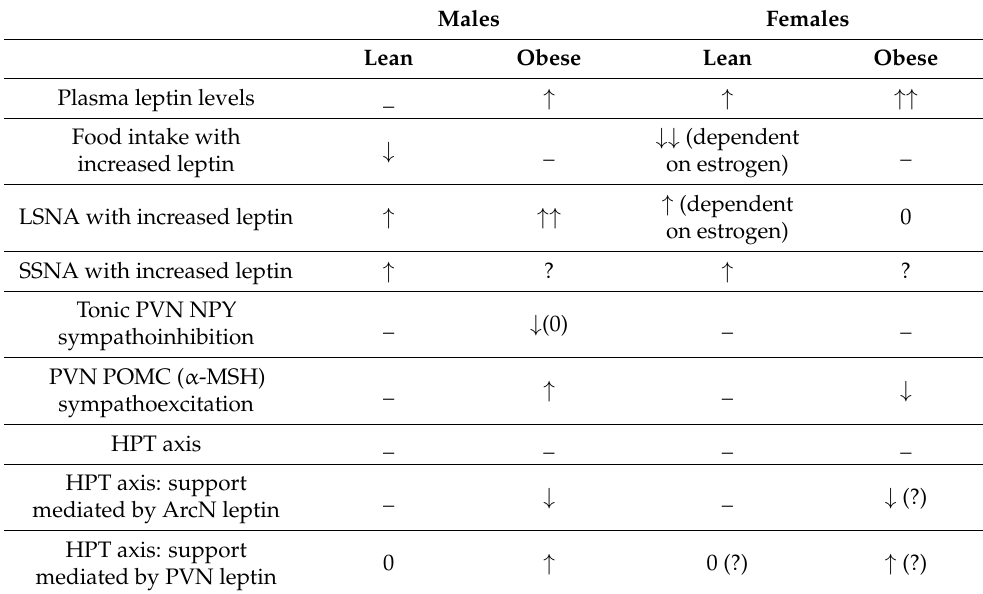
Table 2. While the increased leptin levels that occur with obesity fail to suppress food intake in both sexes, its actions to increase SNA are increased in males (which can cause hypertension) but nullified in females (obese reproductively active females do not exhibit increased SNA). These sex differences appear to pivot on differential changes in the ArcN. More specifically, obese males exhibit sustained suppression of tonically inhibitory